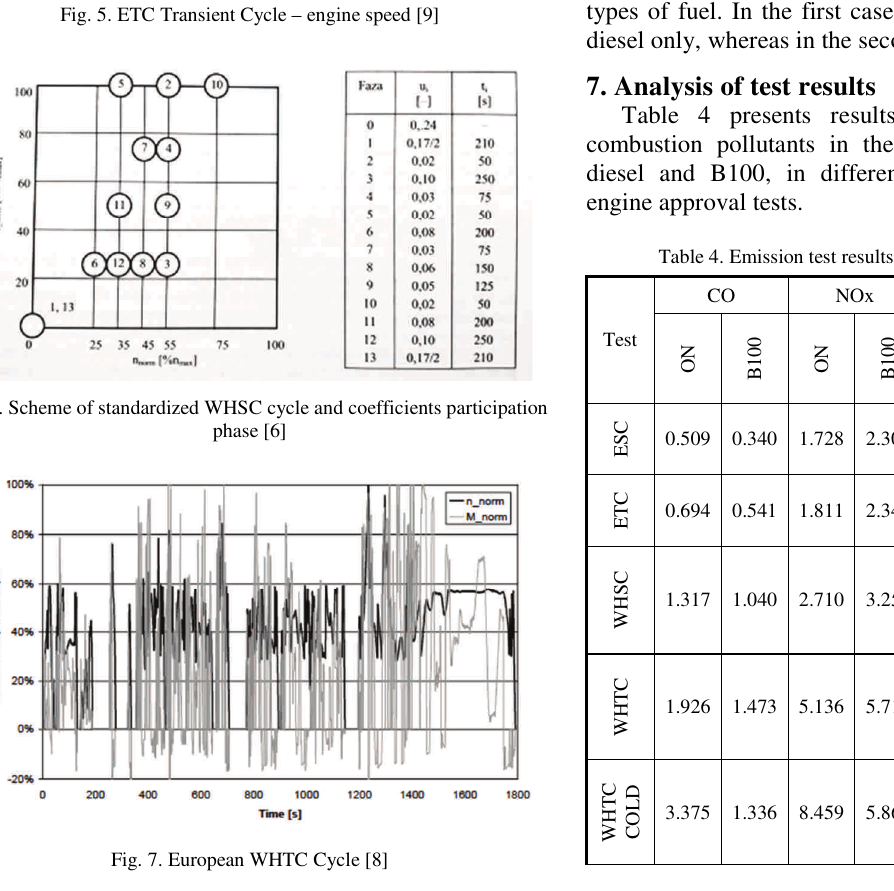
Fig. 5. ETC Transient Cycle – engine speed [9]